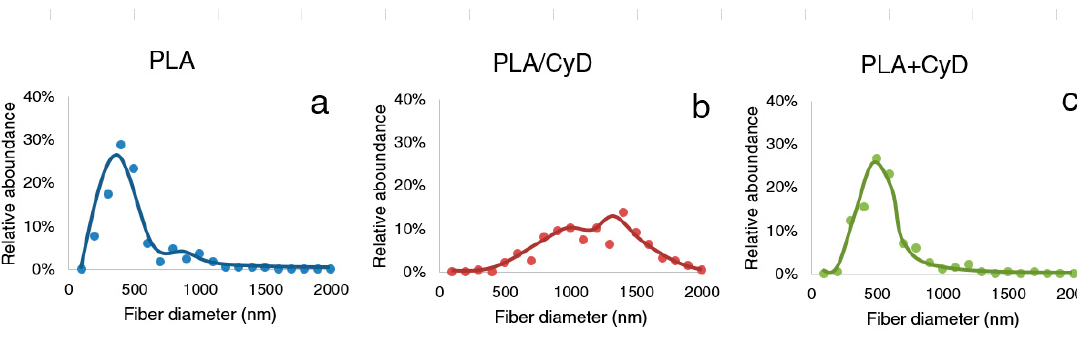
Figure 2. SEM pictures of ( a ) PLA, ( b ) PLA / CyD, and ( c ) PLA + CyD electrospun nanofibers.